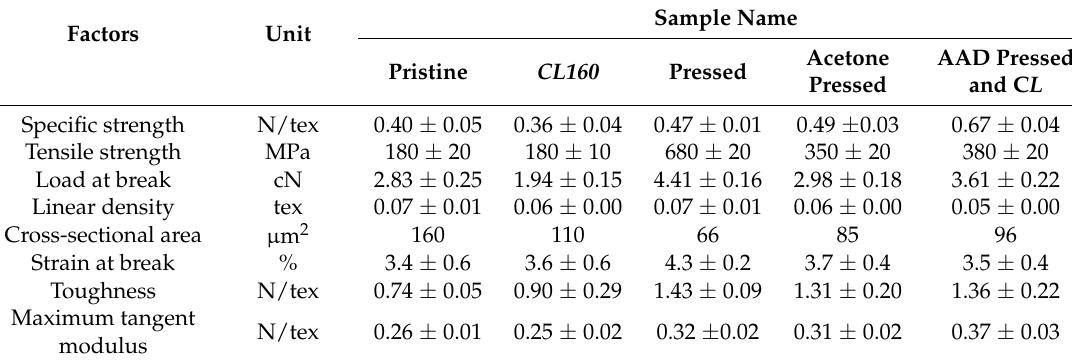
Table 3. The average ± s.d. (6 ≤ n ≤ 8) mechanical properties of